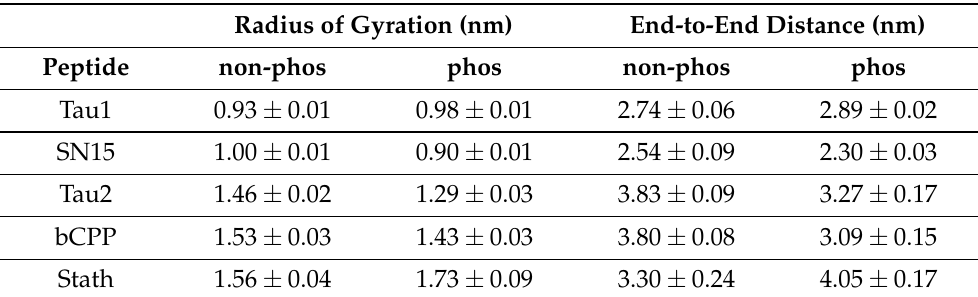
Table 2. Average radius of gyration (R g ) and end-to-end distance (R ee ) of the non-phosphorylated (non-phos) and phosphorylated (phos) variants. Data for SN15 are obtained from [20] and for the phosphorylated peptides of Tau2, bCPP, and Stath from [31].